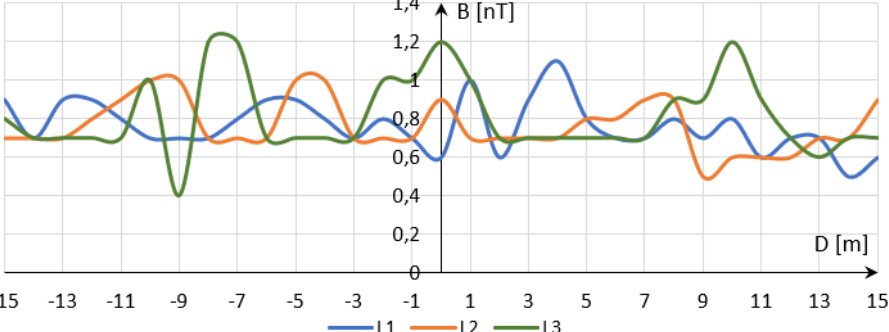
Figure 8. Distribution of magnetic field induction B along L1, L2, L3 phase conductors of the 15 kV container power line No. 1, VLF frequency range.